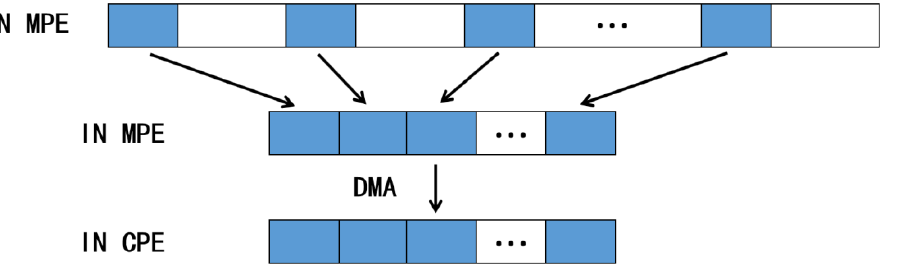
Figure 5. Data storage order adjustment.